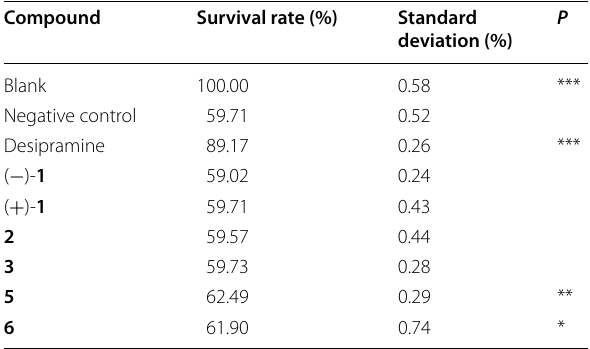
Table 4 Protective activities of selected compounds